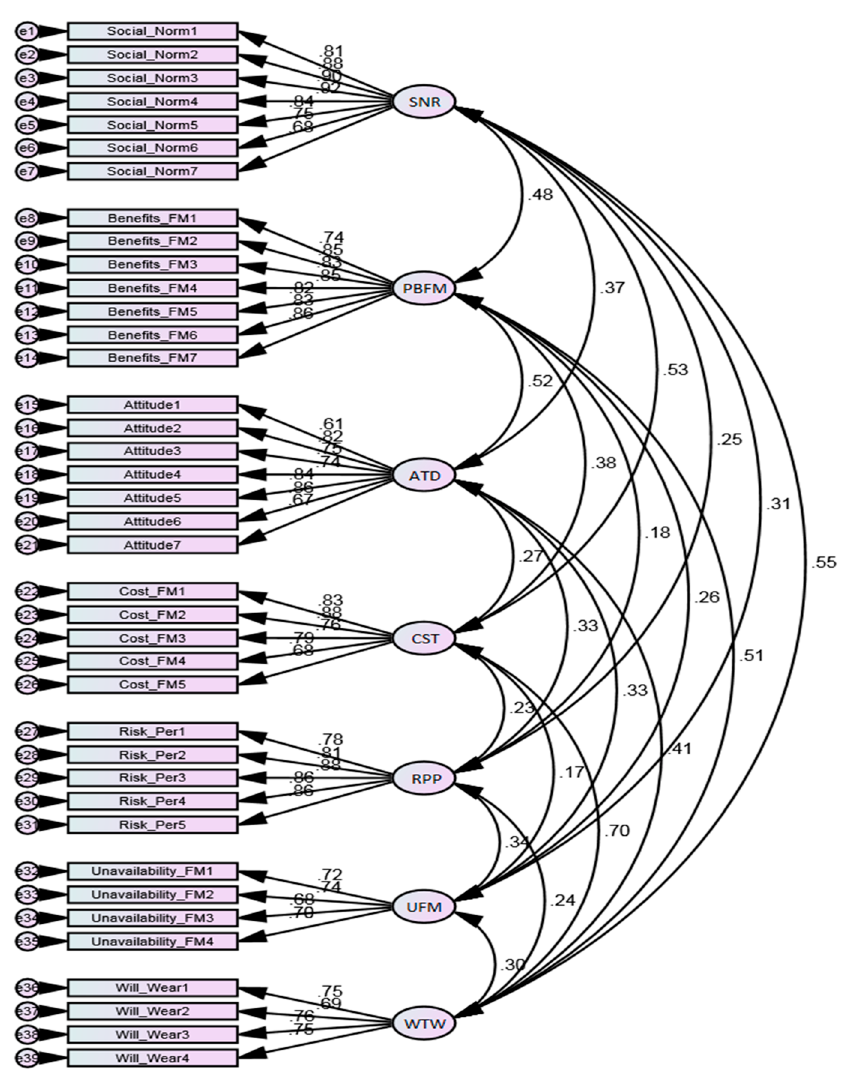
Figure 4. Measurement model. Notes: All items are loaded on their respective constructs, confirming the content validity of the measurement model. The model also supports discriminant validity, as the outer loading for all constructs are less than 0.80. Convergent validity is validated as well, as the inner loadings for all constructs are greater than 0.70.